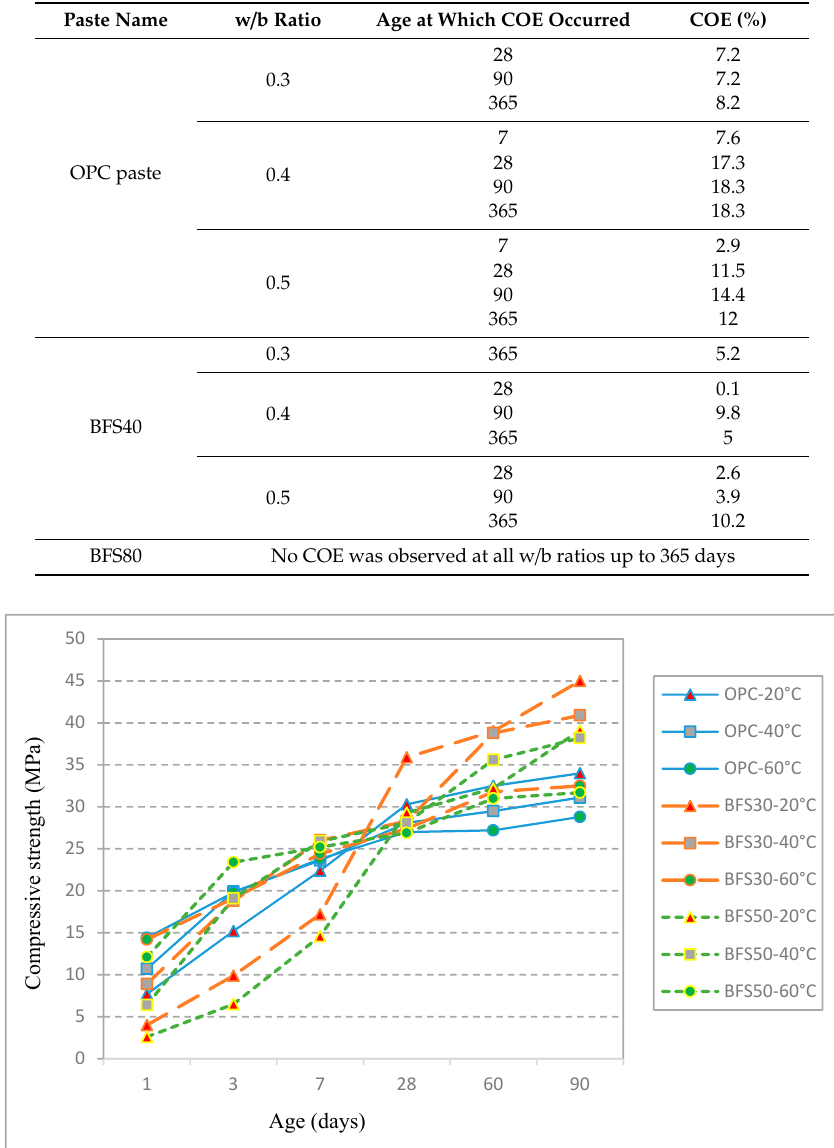
Table 2. COE records with 20–60 ◦ C increase in water curing temperature at ages up to 365 days for ordinary Portland cement (OPC), BFS40 and BFS80 pastes.